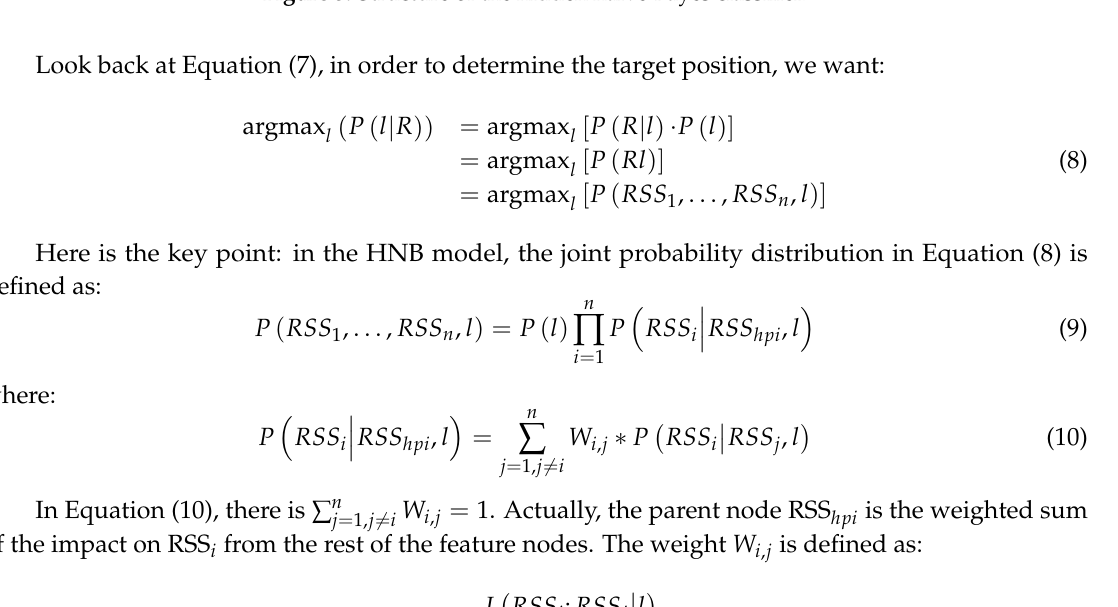
Figure 5. Structure of the hidden naive Bayes classifier.